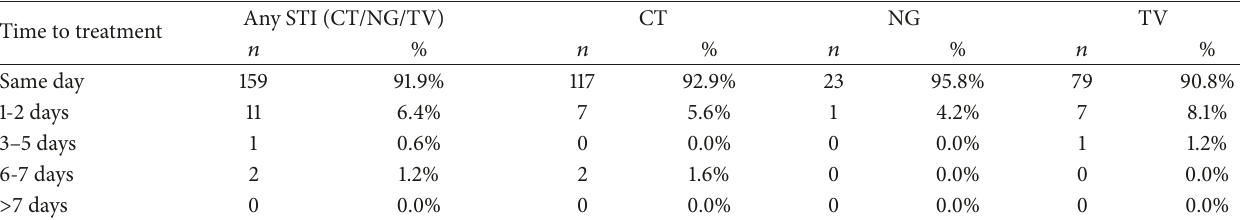
Table3:TimetotreatmentamongHIV-infectedpregnantwomenwhotestedpositiveforCT,NG,andTVinthreeclinicsinTshwaneDistrict, South Africa. Time to treatment Same day